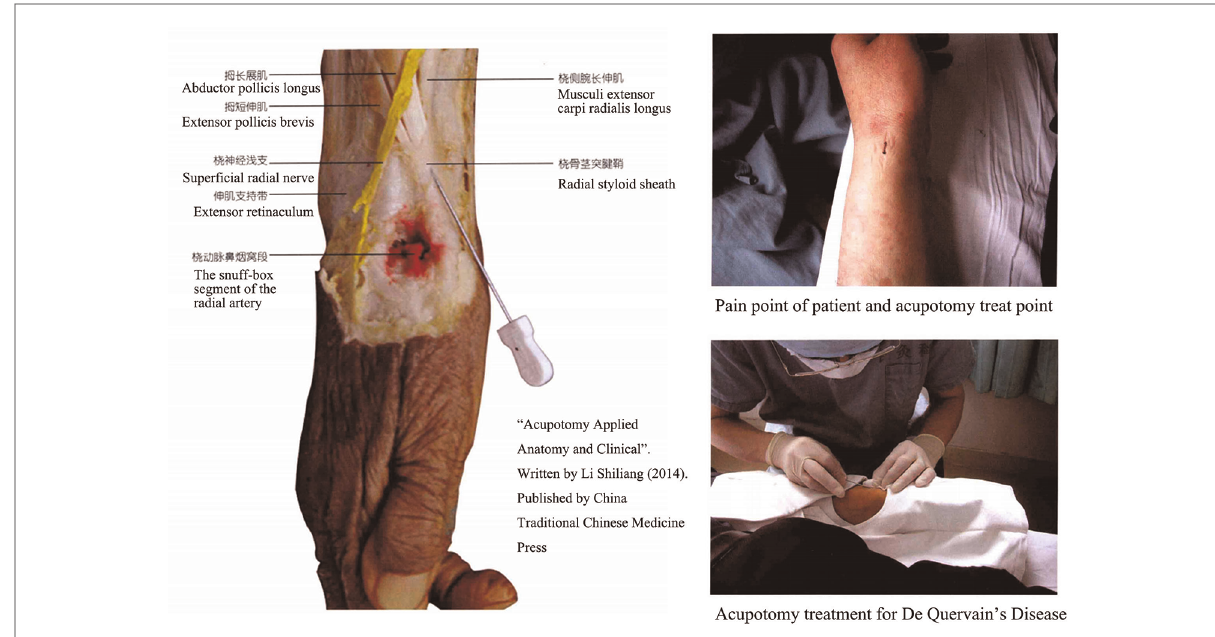
FIGURE 2 Chapter of De quervain ’ s disease in “ Acupotomy Applied Anatomy and Clinical ”